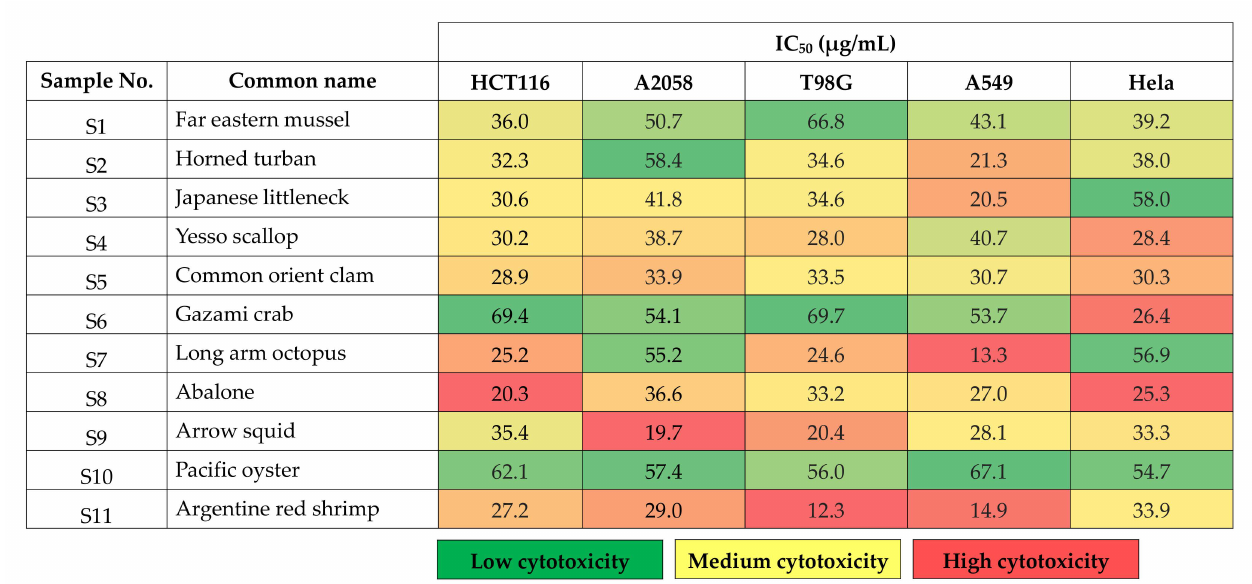
Figure 8. IC50 of eleven shellfish extracted lipids. The green, yellow, and red color explains the low, medium, and high cytotoxicity,